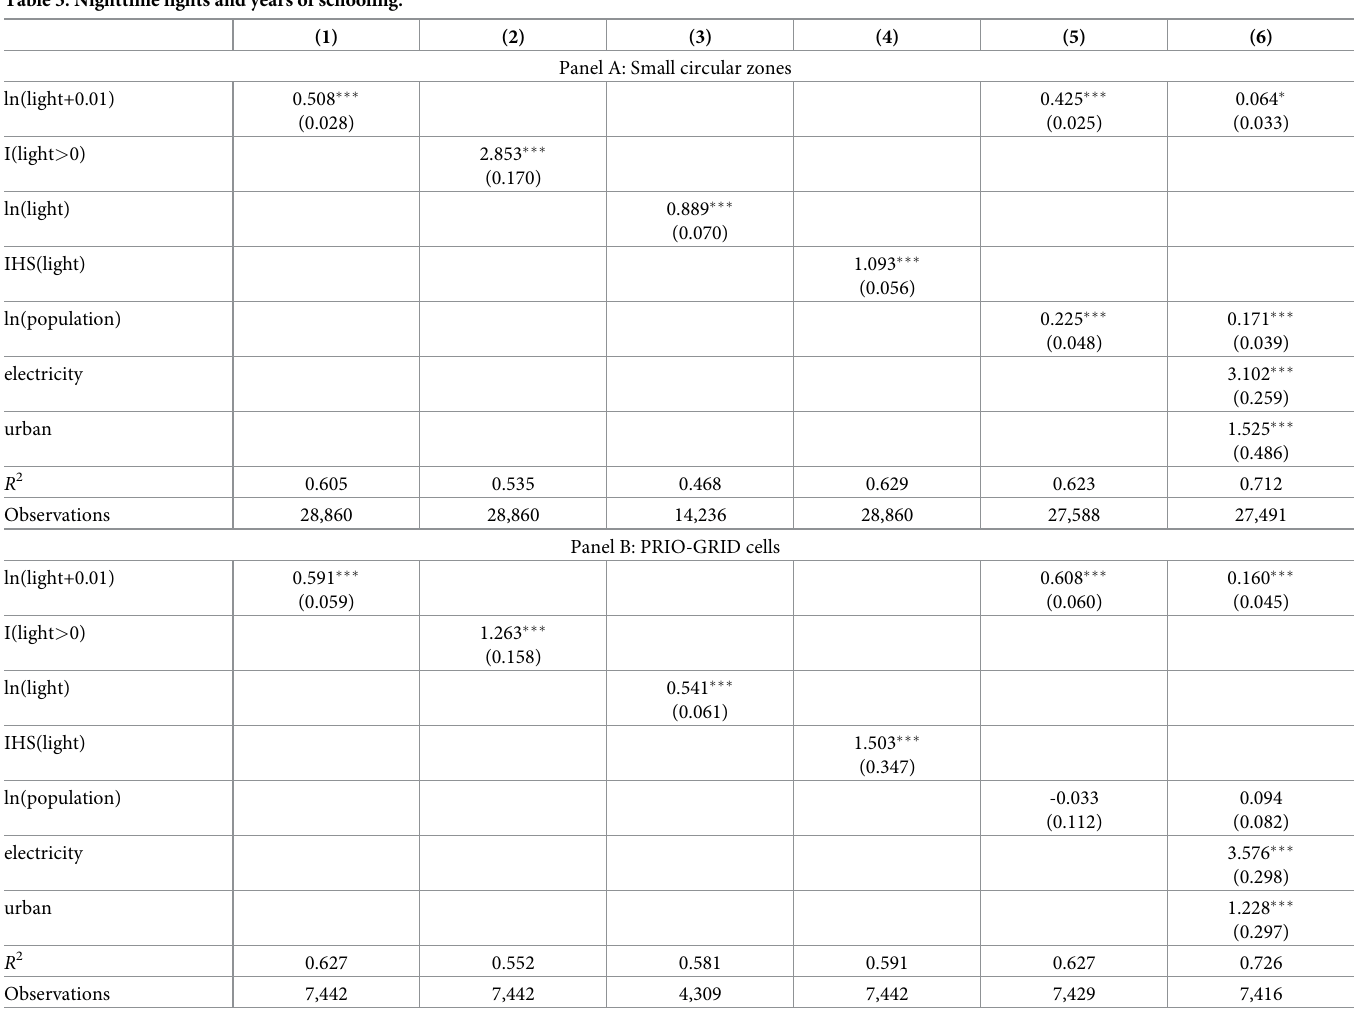
Table 5. Nighttime lights and years of